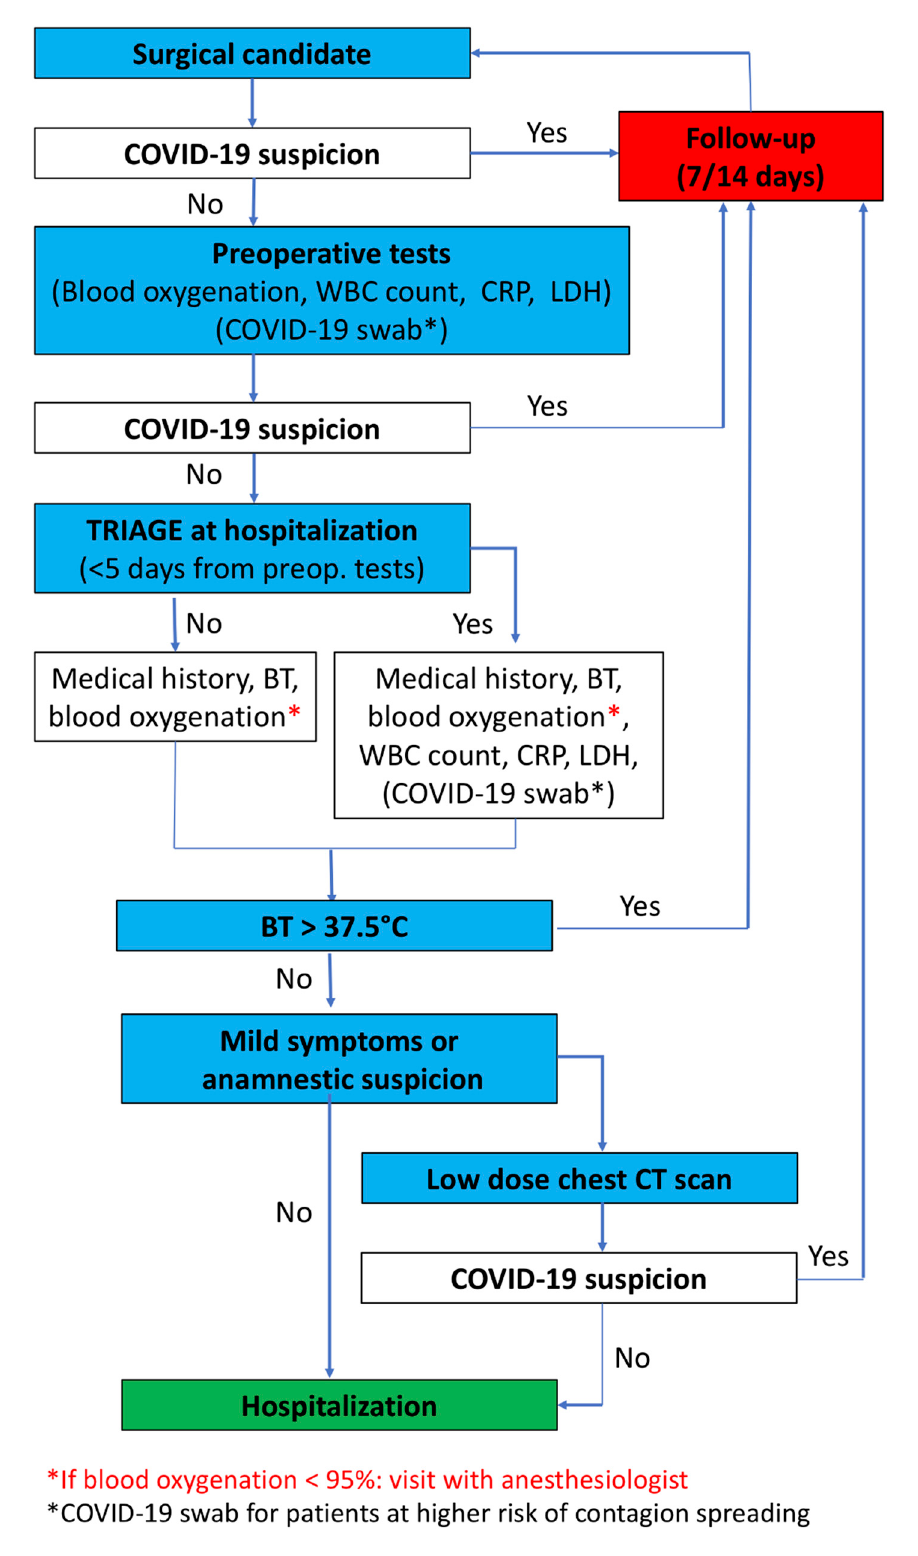
Figure 1. The flow chart describes proposed strategy of surgical patient management to decrease the risk for contagion during COVID-19 pandemic (abbreviation list: white blood cell (WBC), C-reactive protein (CRP), lactate dehydrogenase (LDH), body temperature (BT), computed tomography (CT)).